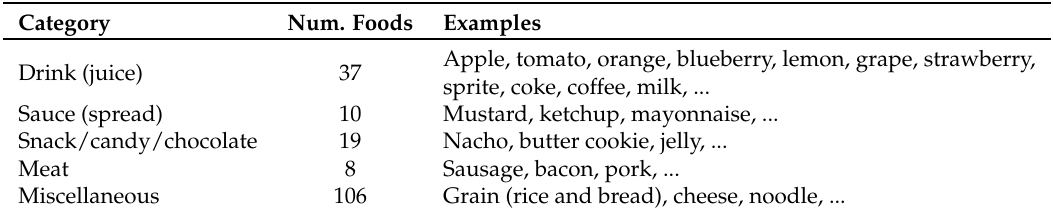
Table 1. List of 140 real foods in 5 categories.